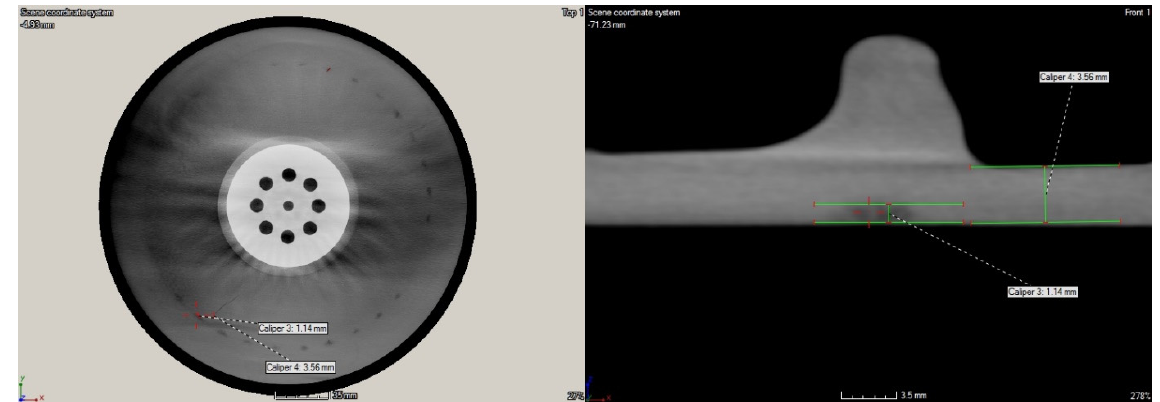
Sensors 2021 , 21 , 7174 Figure 18. The selected detailed views of the tomogram of the larger disk with dimensioned lower density areas.